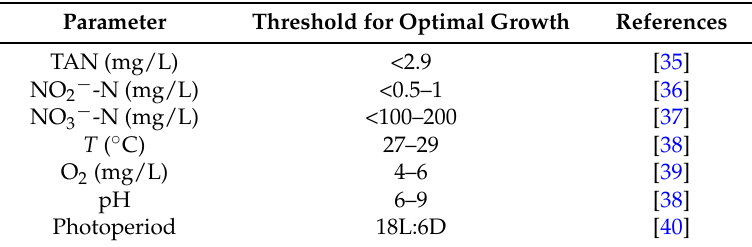
Table 2. Optimal growth parameters for